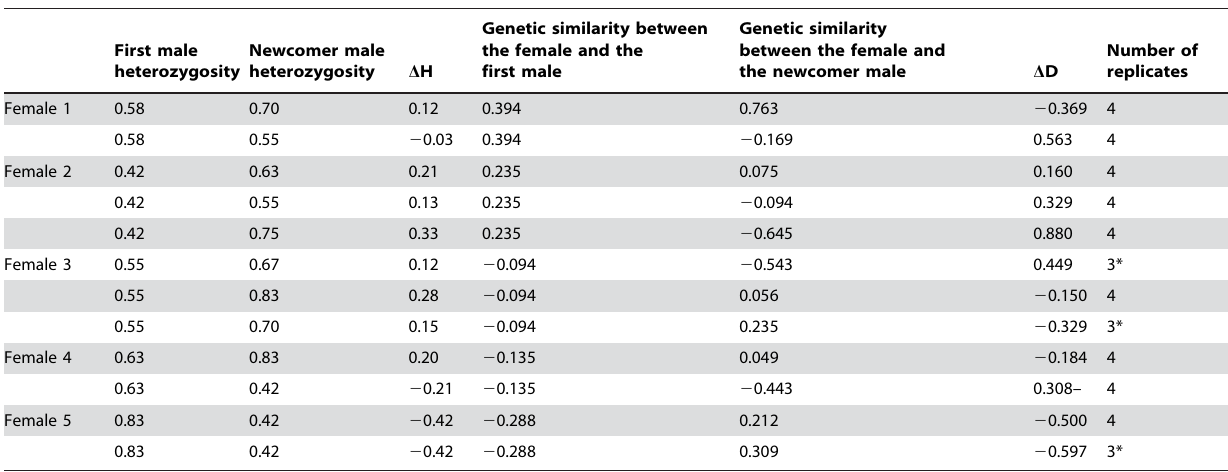
Table 1. Experimental protocol used in tests of divorce.